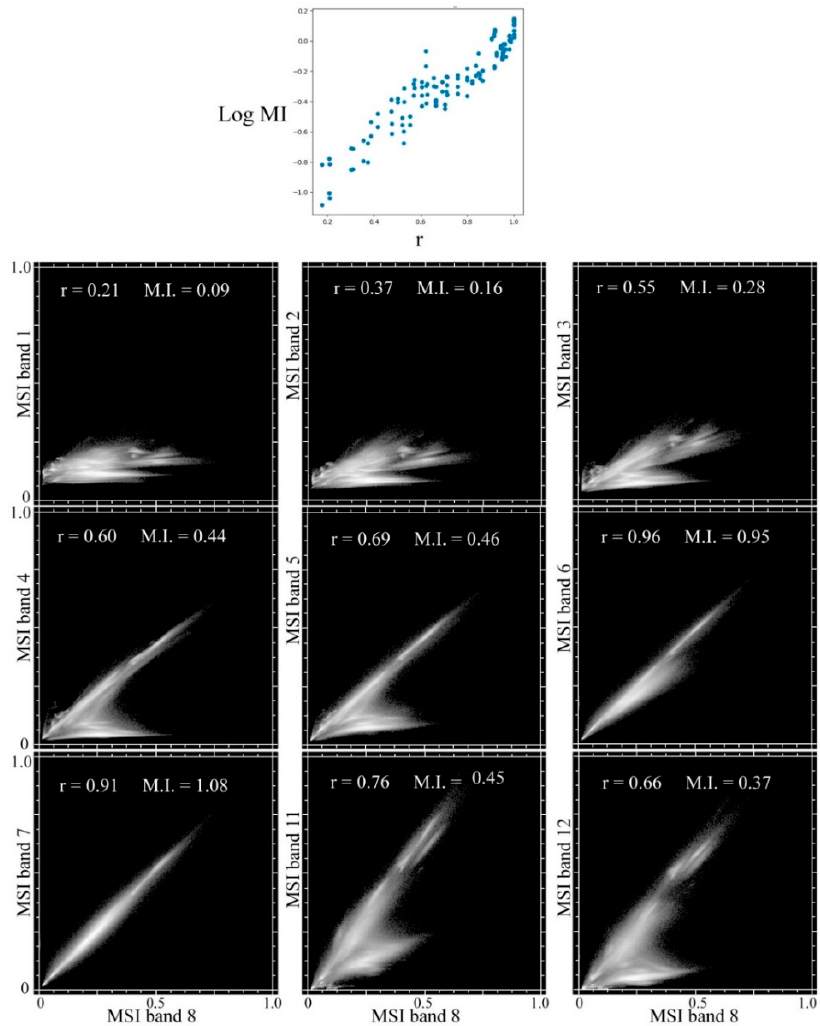
Figure A1. Correlation vs. Mutual Information estimates and band to band bivariate distributions for the 80 land cover specific subset mosaic. For all band to band pairs ( top ) correlation and Mutual Information estimates show a correlation of 0.88 and MI of 1.195 ( r on MI ) and 1.16 ( MI on r ), with some degree of Log-linear scaling on the lower tail of the distribution and clear nonlinearity on the upper tail. The range of both metrics suggests that almost all non-adjacent, and some adjacent, band combinations provide some discriminative utility for at least some land cover subcategories. Bivariate distributions of MSI band 8 with all other bands show considerable deviations from linearity for all but band